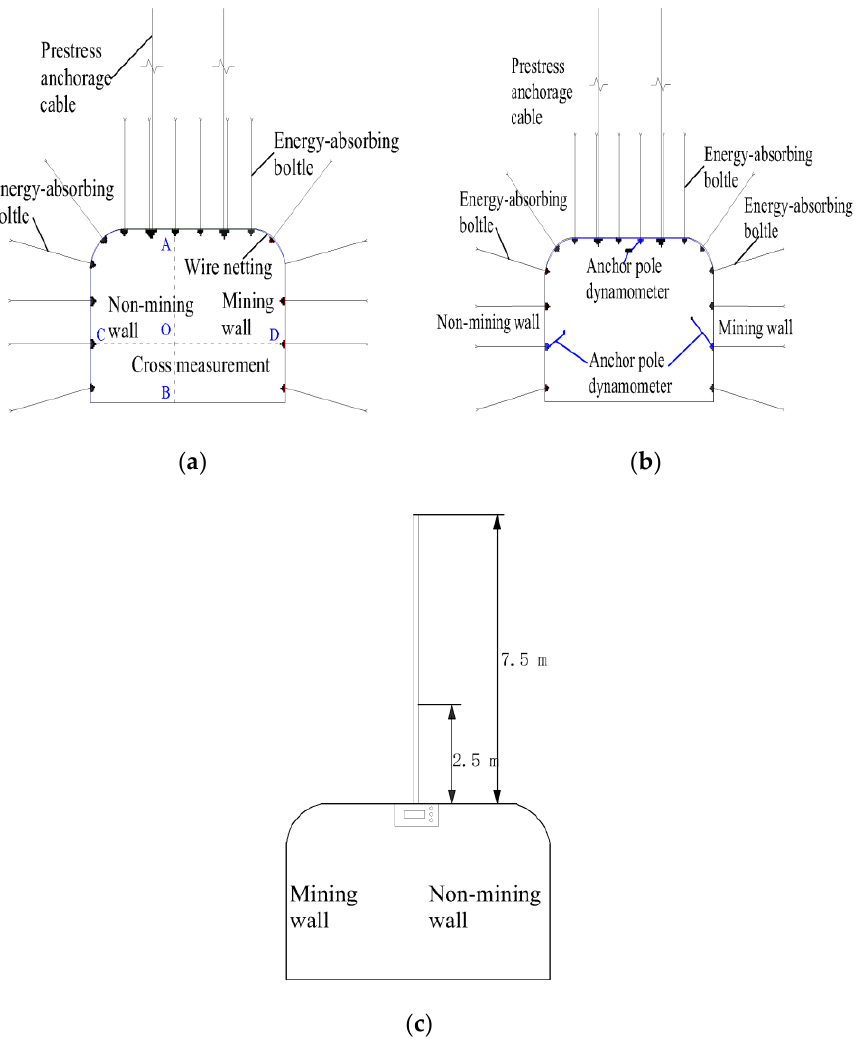
Figure 18. Specific monitoring scheme of 11303 belt chute monitoring area. ( a ) Surface displacement monitoring; ( b ) anchor force monitoring. ( c ) deep displacement monitoring.